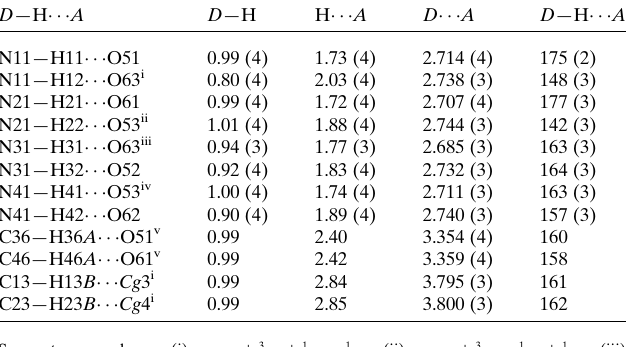
Table 2 Hydrogen-bond geometry (A˚ , (cid:4) ) for (II).